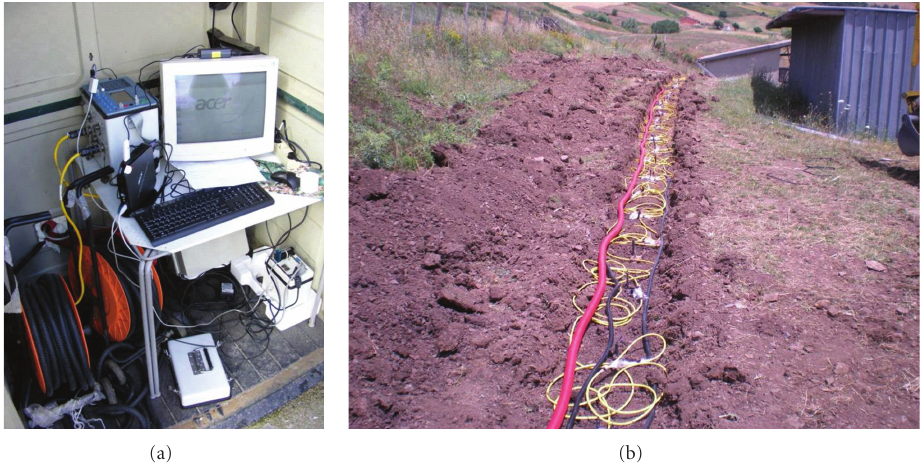
Figure 5: Syscal Pro- and Mini-Trase equipment connect to the pc (a) and the 48-channel ERT monitoring system